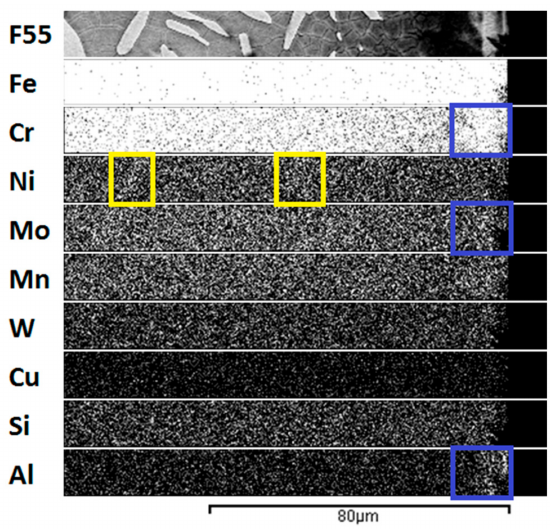
Figure 9. Scanning electron microscope dispersive X-ray microanalysis (SEM/EDS) elemental maps of the surficial aluminum-diffusion layer in the sample annealed at 1080 ◦ C for 360 s/mm and aluminized at 1100 ◦ C for 2700 s. Ferrite-stabilizer element (Cr, Mo, and Al) surface variation is highlighted in the blue boxes, while austenite-former element (Ni) variation, related to the presence of austenitic precipitates, has been underlined in the yellow boxes.